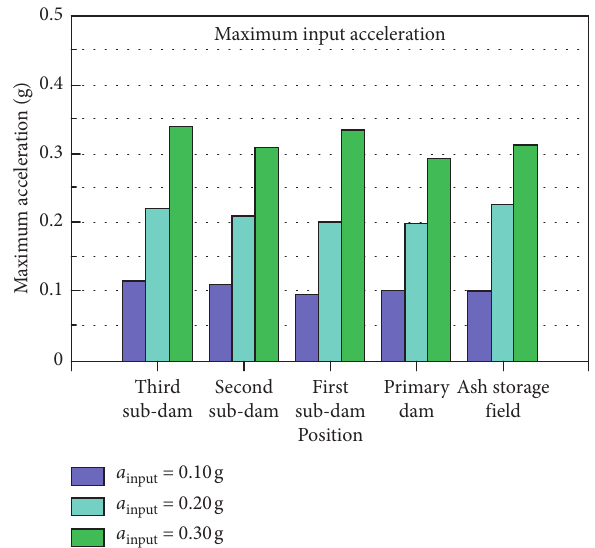
Figure 13: Peak acceleration of various parts of ash storage site under three input earthquakes ( L